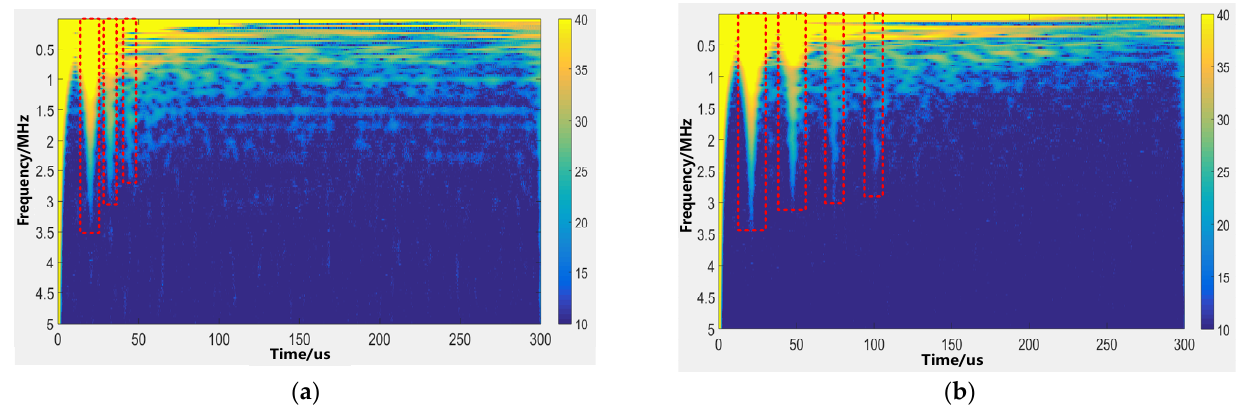
Figure 9. Time–frequency distributions of the transient voltage excited by flashover in a post insulator of an operating GIL. ( a ) Spectrum measured by sensor A (south); ( b ) spectrum measured by sensor B (north).